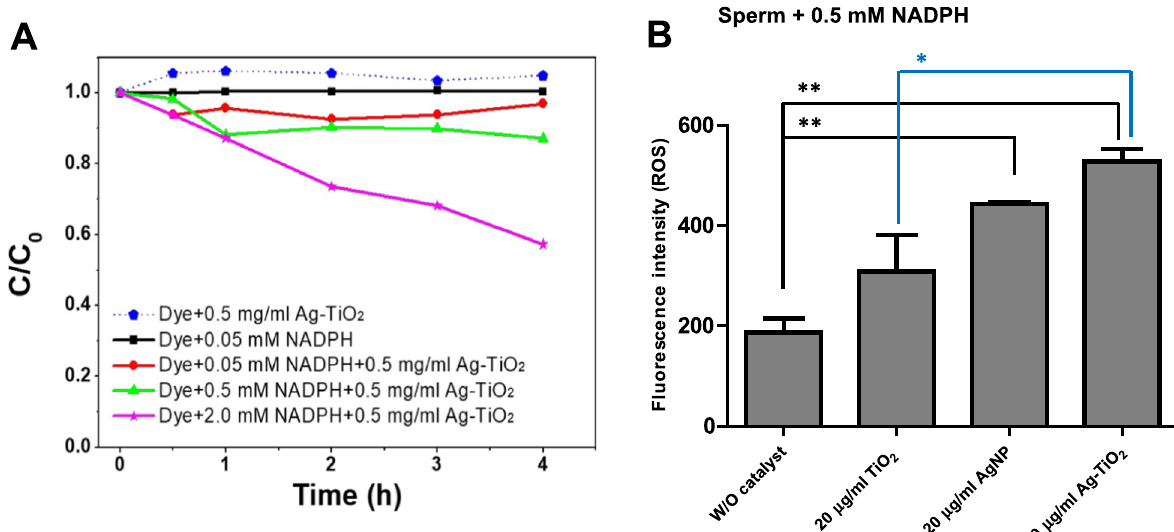
Fig. 7 ROS generation in spermatozoa incubated with Ag‑loaded TiO 2 NRs using NADPH. A Dye degradation of Ag‑loaded TiO 2 NRs in the presence of NADPH. B ROS generation (in sperm) incubated with different catalysts Ag nanoparticles, TiO 2 NRs, and Ag‑TiO 2 NR in the presence of commercial NADPH. Values are expressed as mean SEM. Lines (or dotted lines) among columns denote significant differences at * p < 0.05 and ** p < 0.01 ±